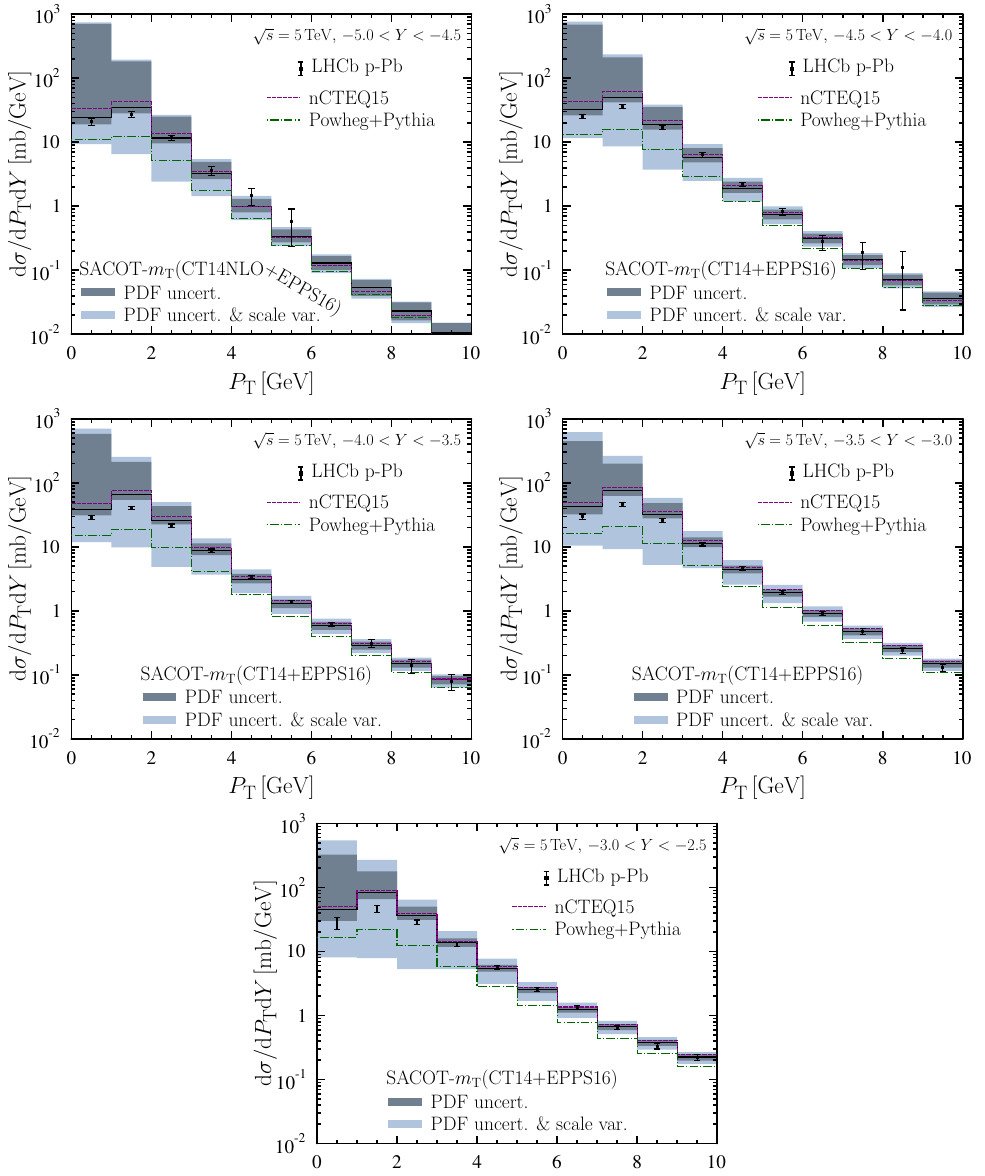
Figure 1 . Double-di(cid:11)erential cross section for D 0 production in p+Pb collisions at p s in (cid:12)ve di(cid:11)erent Y bins at backward rapidities. Data from LHCb [42] are compared to the GM- VFNS calculations with EPPS16 (solid black) and nCTEQ15 (dashed purple) nPDFs, and to a Powheg + Pythia setup with EPPS16 nPDFs (dot-dashed green). The theoretical uncertainties related to the PDFs are shown with dark grey and the combination of the scale variations and PDF uncertainties with light blue.